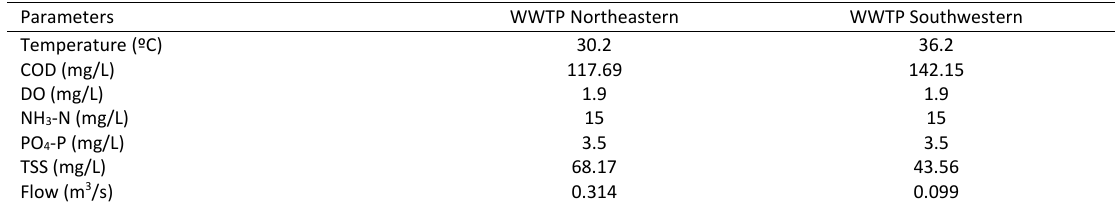
Table 2: Evaluation criteria for RMSE